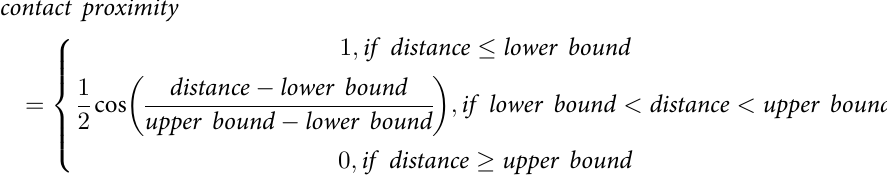
S1 Table. Residue number and starting sequence of protein benchmark set used for design.